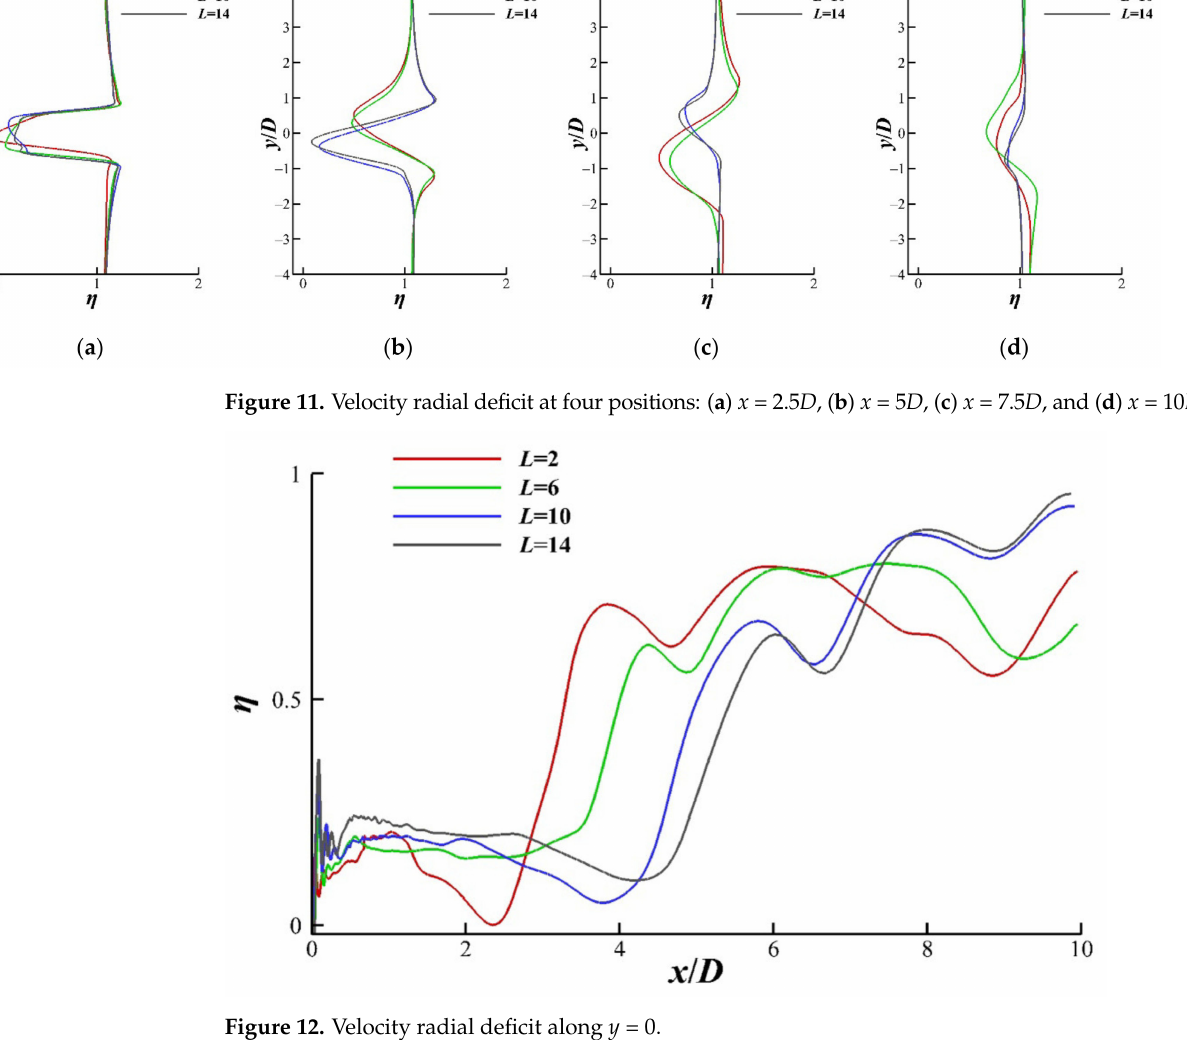
Figure 12. Velocity radial deficit along y =